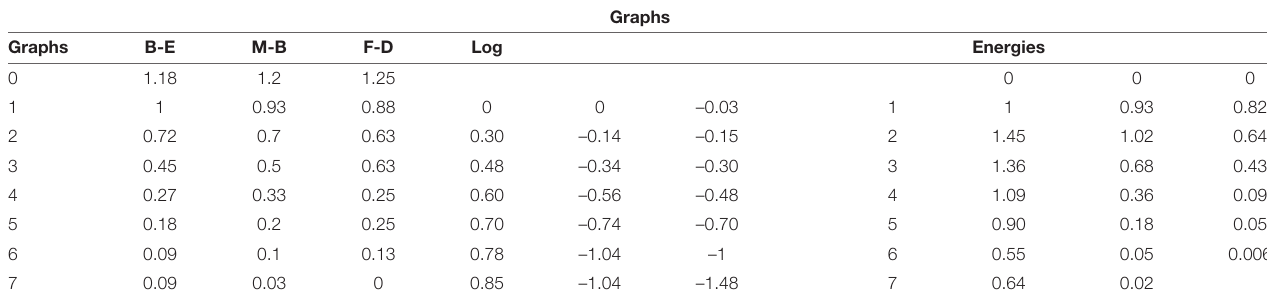
TABLE 3 | The calculated data for the Bose-Einstein, Maxwell-Boltzmann and Fermi-Dirac functions belonging to the example of “four words distributed over seven energy levels with total energy equal to seven,” whose raw data and previous calculated data can be found in Table 2 . Graphs